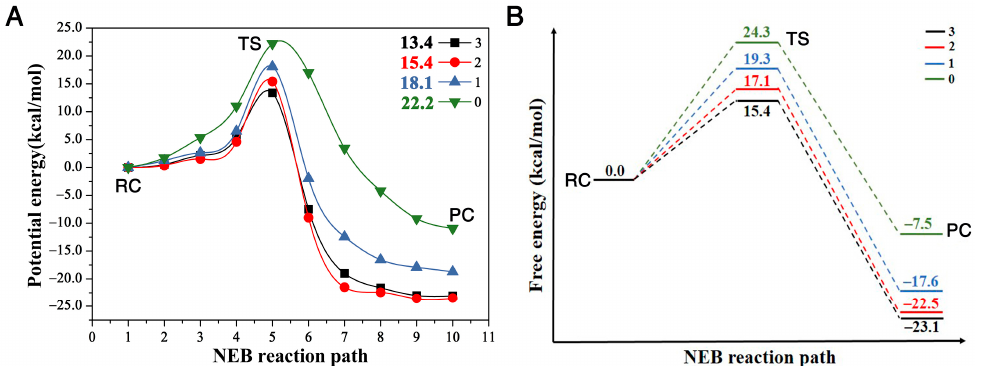
Figure 3. ( A ) is the potential energy of AcO − + DCE reaction in the presence of three (Trp125 + Phe172 + Trp175), two (Trp125 + Trp175), one (Trp125), and zero residues, along the NEB reaction path, respectively; ( B ) is a schematic plot of the reaction profile showing the free energies at the stationary points along the NEB reaction path. (RC, TS and PC repreScheme 0. Å for the reaction without any residues. The order of this D cat descriptor with different numbers of residues is D cat ( 3 ) > D cat ( 2 ) > D cat ( 1 ) > D cat ( 0 ) . Therefore, this D cat behavior proves that the presence of the enzyme, even only with one residue, catalyzes the S N 2 reaction of AcO − + DCE . The reactivity order R N is R 3 > R 2 > R 1 > R 0 (N infers the number of